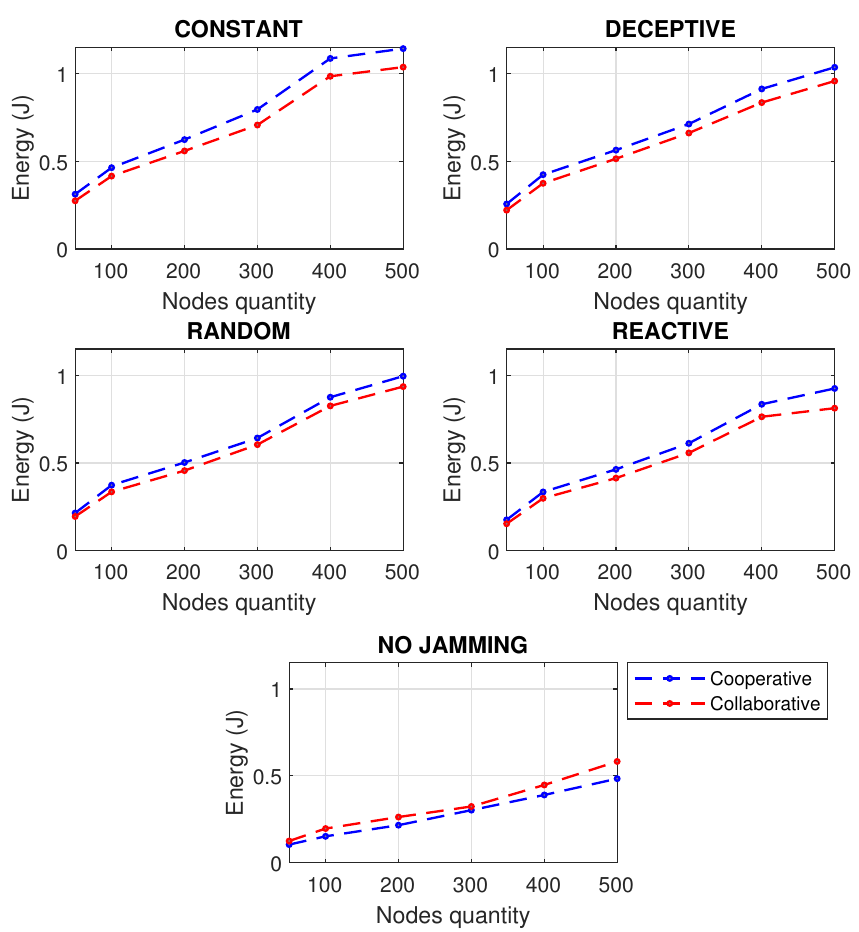
Figure 10. Energy for types of jamming in a WSN of 500 m 2 with different number of nodes under collaborative and cooperative